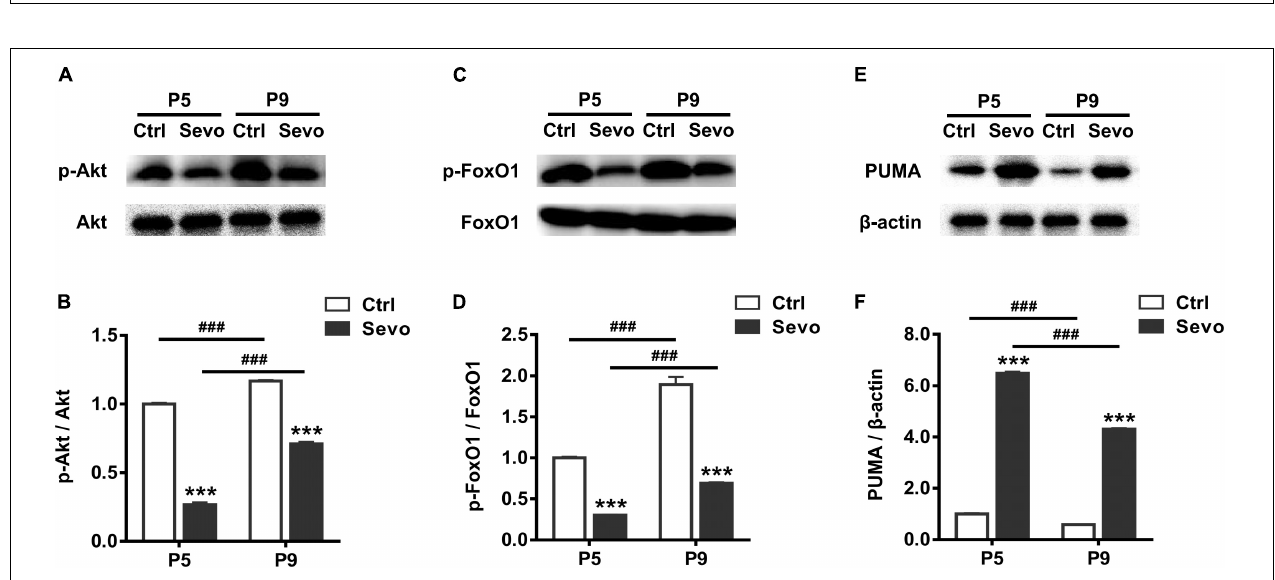
FIGURE 2 | Vulnerability of GABAergic neurons to sevoflurane-induced apoptosis is age-dependent. (A,B) Representative confocal images of S1 sections labeled for cleaved caspase-3 (CC3, red), GAD67-GFP (green), and TOPRO (blue) at P5 (A) and P9 (B) . The cortical layers are indicated by Roman numerals. Conditions are as indicated. White arrowheads indicate CC3 + cells co-localized with GAD67-GFP, while the white arrows indicate those that are not co-localized. The scale bar is 100 µ m. Zoomed images of boxed regions are presented to the right of each panel with scale bars = 50 µ m. (C) Proportion of CC3 + cells co-labeled with GAD67-GFP in all cortical layers. Three to four mice were used for each condition. *** , P < 0.001, using two-way analysis of variance followed by Bonferroni post hoc tests. Data are shown as the mean ± standard error of the mean.